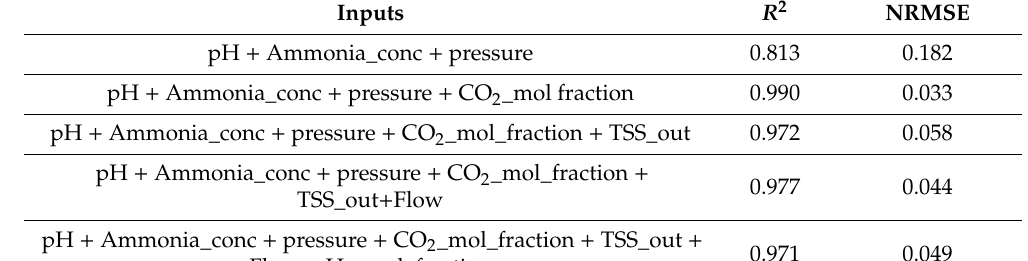
Table 5. Result of different subsets trained by support vector machine (SVM).